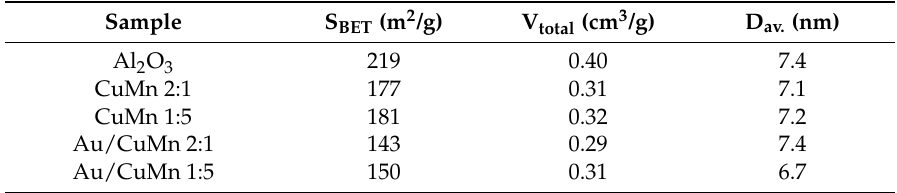
Table 1. The specific surface area (S BET ), total pore volume (V total ), and average pore diameter (D av. ) as estimated by physisorption measurements.